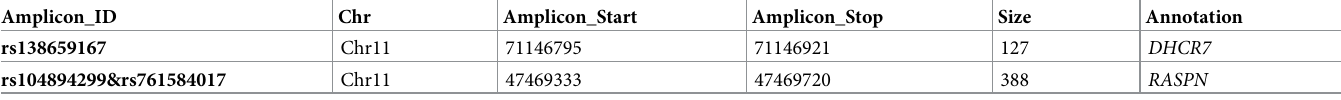
unmatched gap inside a mapped read. The mapped results were processed with an R script (S5 File) used in the main shell script to extract SNPs and reconstitute a new sequence with CIGAR information. The new concise sequences were tabulated and grouped with sequence